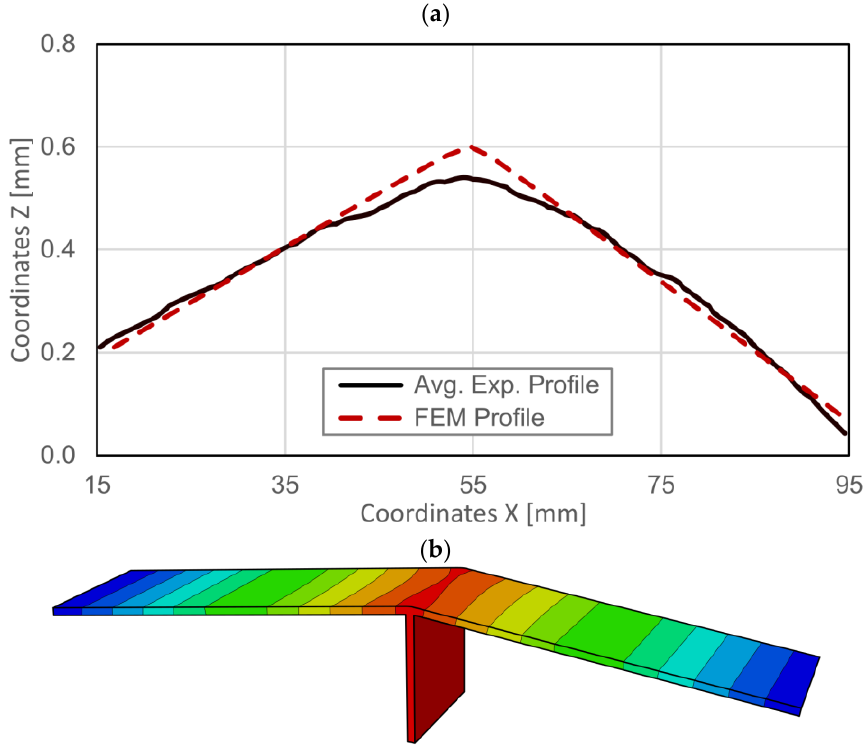
Figure 11. Distortions of the optimum case after welding: ( a ) Experimental comparison and ( b ) FEM vertical displacements.